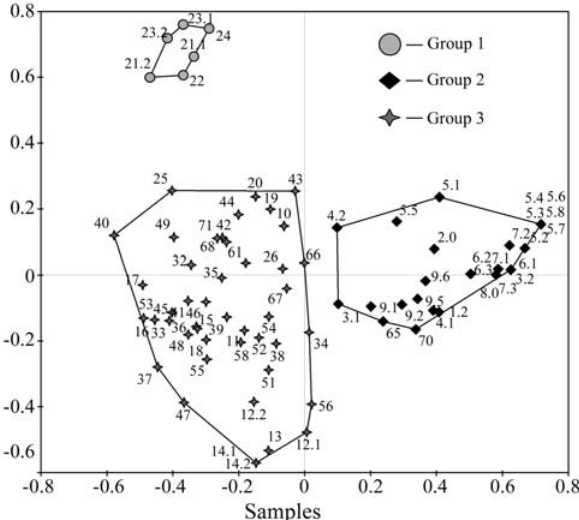
Figure 3 - Scatter graph of the 78 sweet potato ( Ipomoea batatas ) acces- sions (landraces and putative clones) collected in the Vale do Ribeira, São Paulo.Thefirstprincipalcoordinate,bottomaxis,explained14.48%ofthe total variation and the second principal coordinate, left axis, explained 7.40% of the total variation.